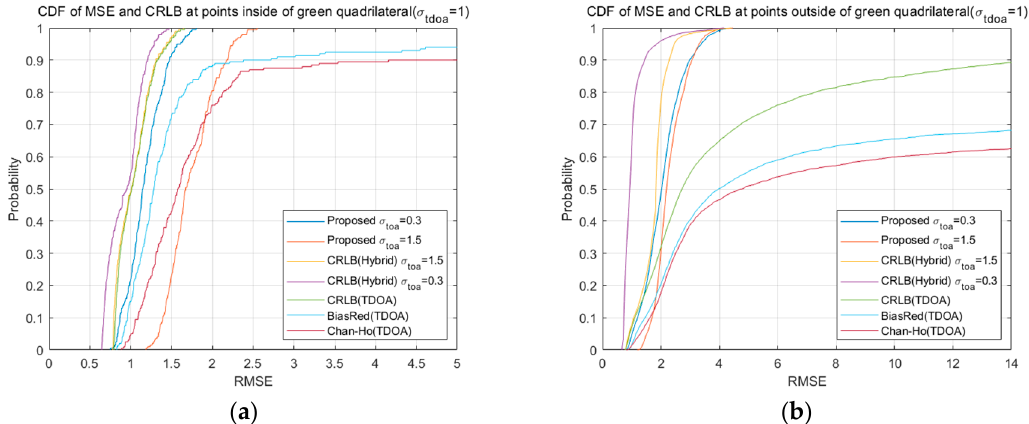
Figure 15. CDF of root mean square error (RMSE) different positioning method when σ tdoa = 1 m; ( a ) CDF of RMSE of points inside green quadrilateral; ( b ) CDF of RMSE of points outside green quadrilateral.